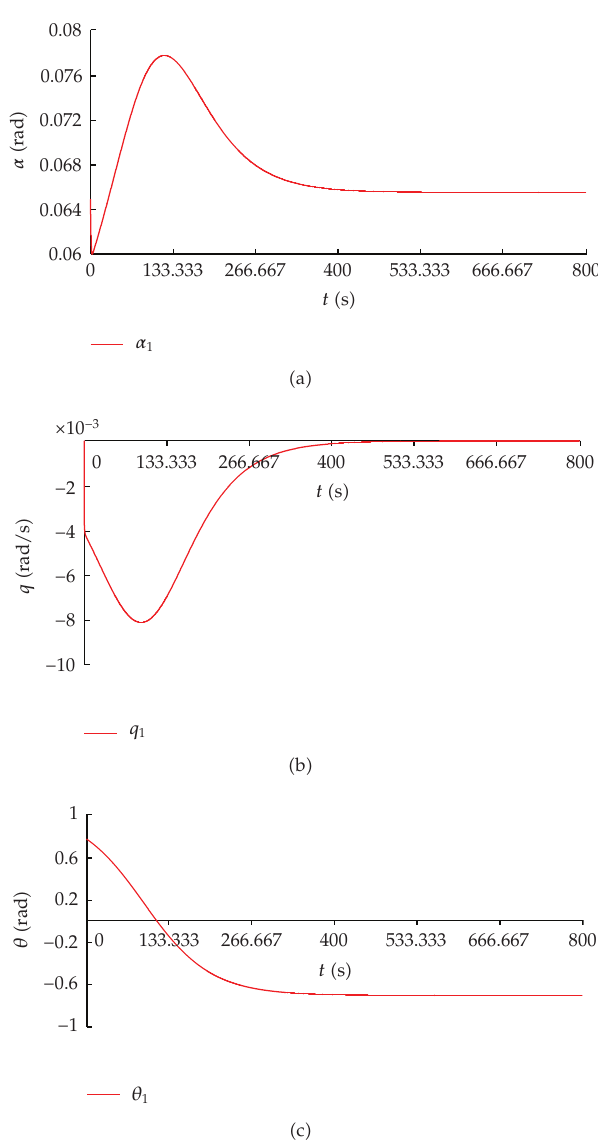
Figure 10: A transfer of an equilibrium, which belongs to P 2 , into an equilibrium which belongs to P 1 (cid:3) simulated in the general model (cid:4) : δ (cid:6) (cid:7) − 0 . 03866 (cid:5) rad (cid:6) (cid:7) 2 . 216 ◦ → δ (cid:6)(cid:6) e (cid:7) 0 (cid:5) rad / s (cid:6) ; θ (cid:6) (cid:7) 0 . 7674624 (cid:5) rad (cid:6) (cid:7) 43 . 994 ◦ → α (cid:6)(cid:6) 0 . 064883 (cid:5) rad (cid:6) (cid:7) 3 . 719 ◦ ; q (cid:6) 2 2 (cid:7) 0 (cid:5) rad / s (cid:6) ; θ (cid:6)(cid:6) (cid:7) − 0 . 6980667 (cid:5) rad (cid:6) (cid:7) − 40 . 016 ◦ instead of α (cid:6) q (cid:6)(cid:6) 1 1 (cid:7) 0 . 7674624 (cid:5) rad (cid:6) (cid:7) 43 . 994 ◦ → α (cid:6)(cid:6) (cid:7) 0 . 046845 (cid:5) rad (cid:6) (cid:7) 2 . 685 ◦ ; q (cid:6)(cid:6) θ (cid:6) 2 2 59 . 428 ◦ .